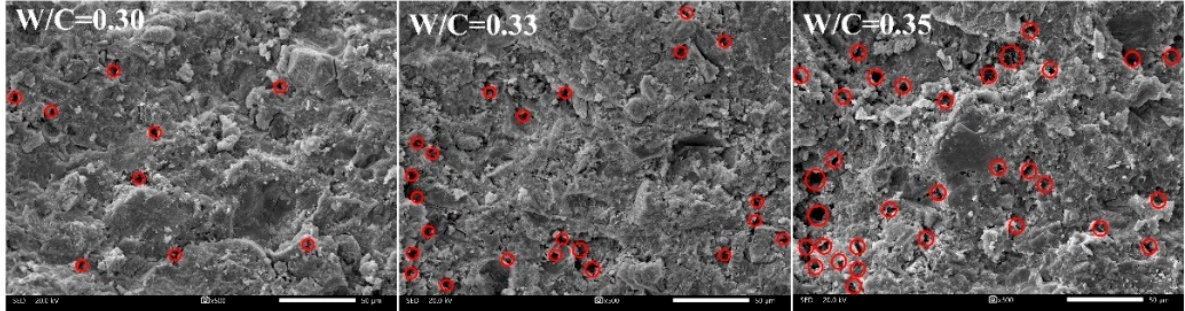
Figure 4. The internal microscopic characteristics magnified 500 times under different conditions of WCR.